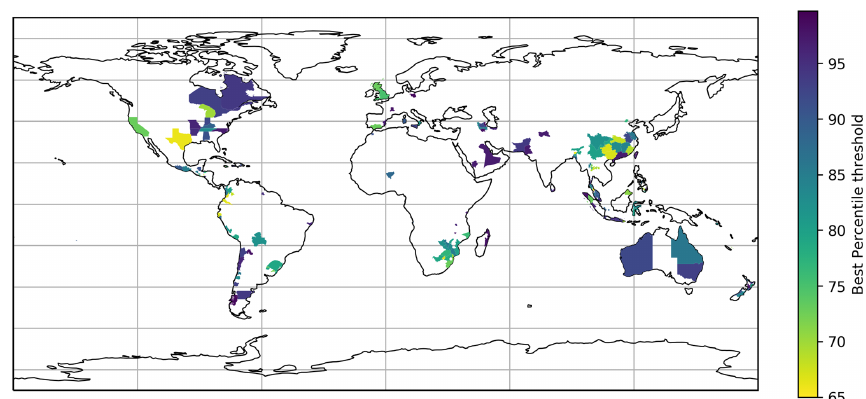
Figure 9. Global map showing the tweet percentile threshold which yielded the highest F2 score of precision/recall between filtered heavy rainfall tweet activity and events in the Met Office impact database for each GADM level 1 administrative area with an event recorded in the Met Office database during the study period.